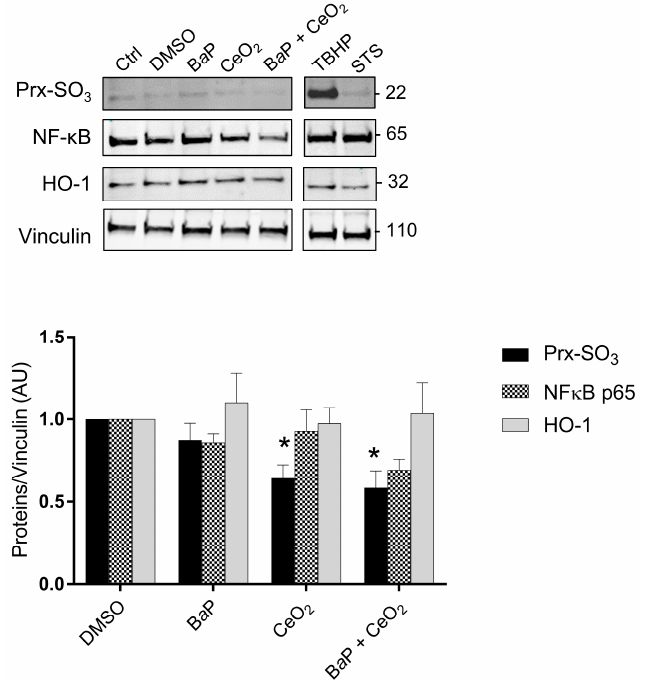
Figure 5. Intracellular oxidative stress after trophoblast exposure to benzo(a)pyrene and/or cerium dioxide nanoparticles. VCT purified from term placentas were plated overnight and were untreated (control) or incubated with DMSO, B a P (0.6 µM), or CeO 2 NP (6.3 µg/cm 2 ) and in co-exposure for 24 h. Tert -butyl hydroperoxide (TBHP, 100 µM, 4 h) and STS (0.5 µM, 3 h) were used as positive controls for oxidative stress and apoptosis, respectively. Total protein extracts were subjected to SDS-PAGE under reducing conditions and membranes were immunoblotted with anti-Prx-SO 3 , anti-NF κ B p65, anti-HO-1, and anti-vinculin antibodies (loading control). Immunoblots were quantified with an Odyssey System Imager and the results represent the mean +/ − SEM after normalization to vinculin ( n = 5). * p < 0.05 vs. DMSO.